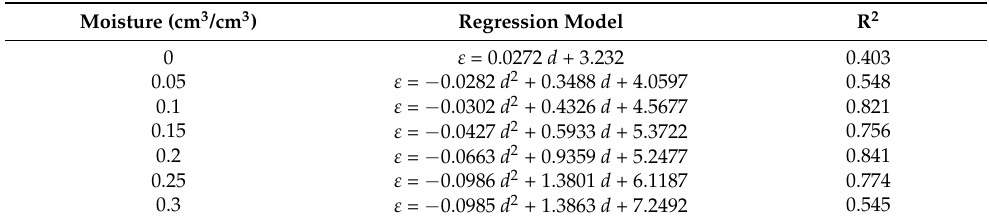
Table 2. Mathematical dependences between sample thickness (cm) and apparent permittivity values read by Sensor A, for particle sample moisture.